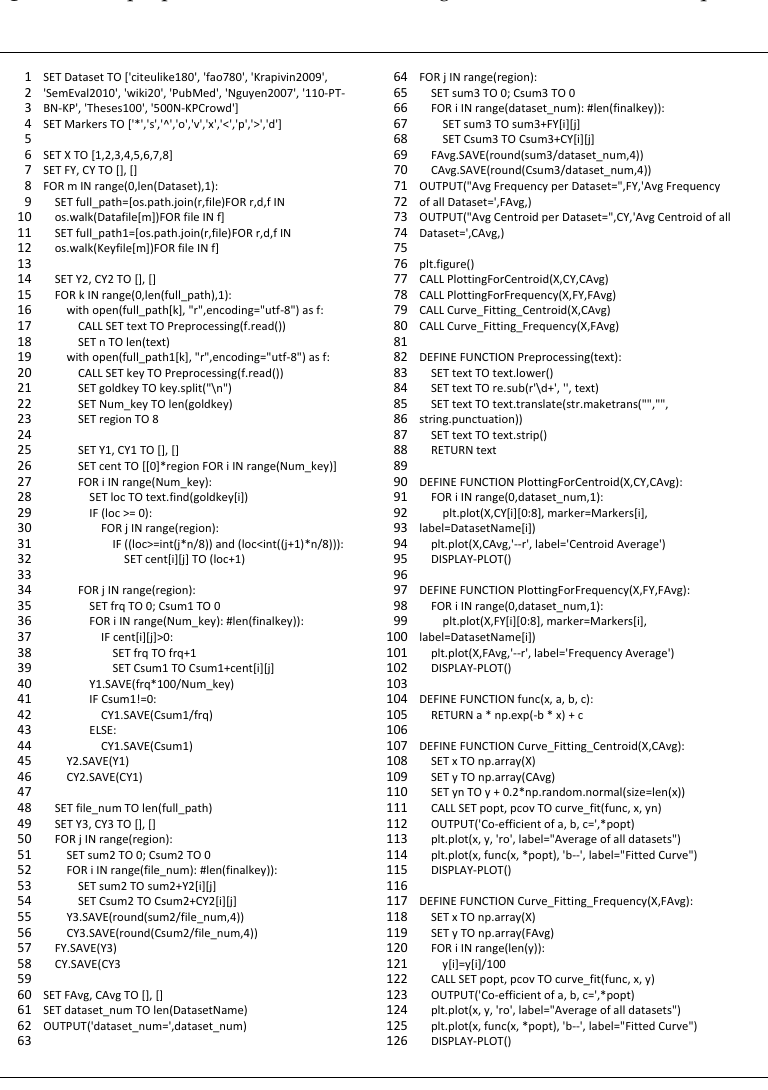
Figure 1. The proposed architectural flow diagram for the KCFA technique.